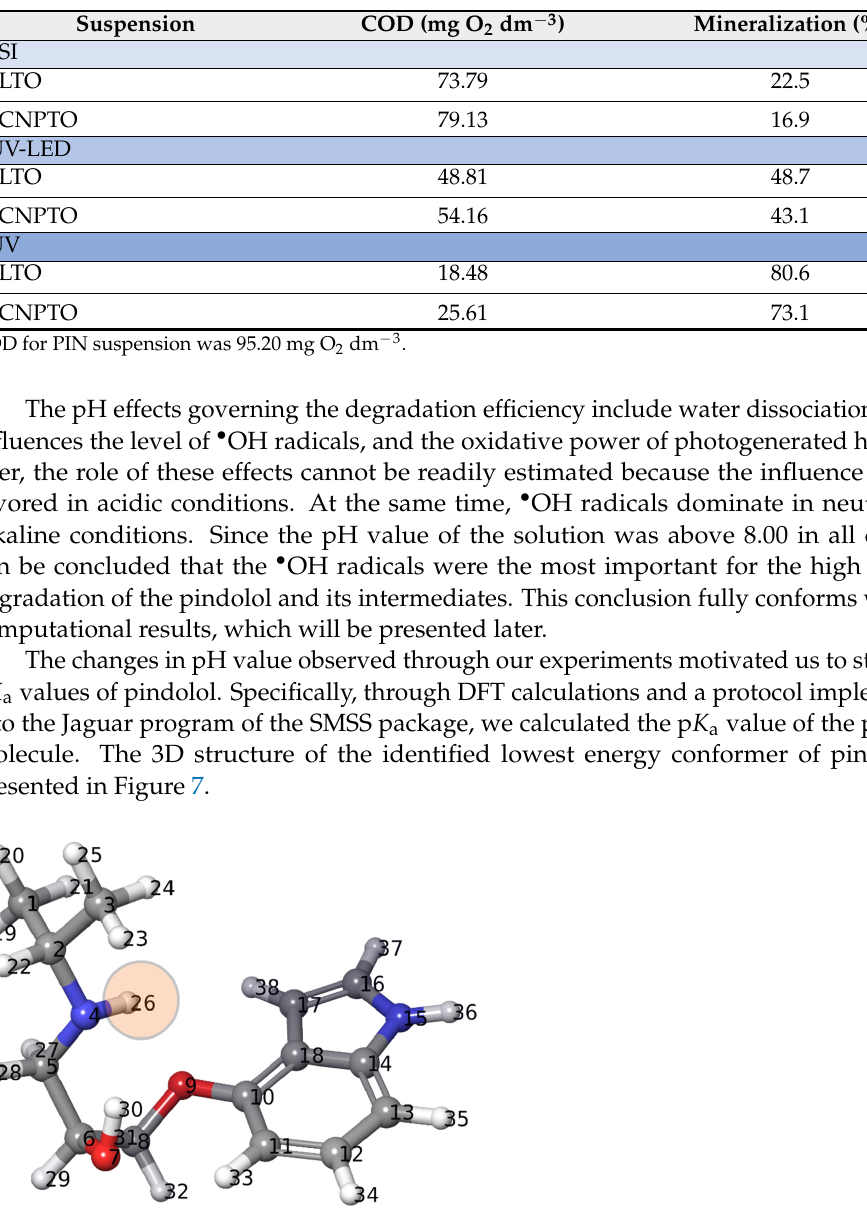
Figure 7. Optimized structure of pindolol used for the calculation of p K a value.